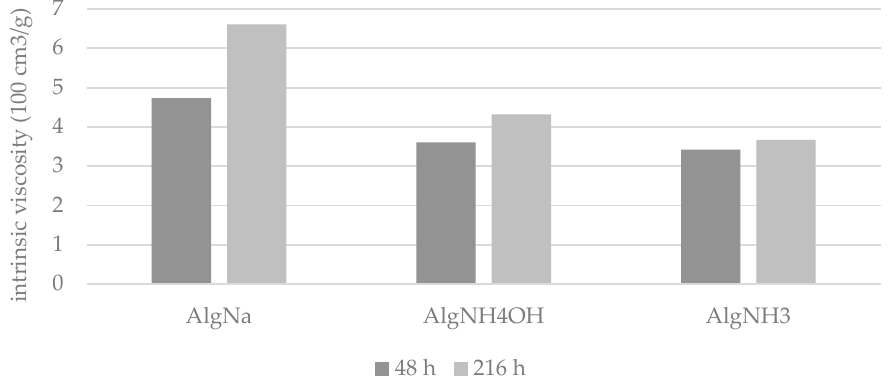
Figure 3. The comparison of the intrinsic viscosity values of ammonium alginates obtained by two methods in reference to aqueous solution of sodium alginate after 48 and 216 h.